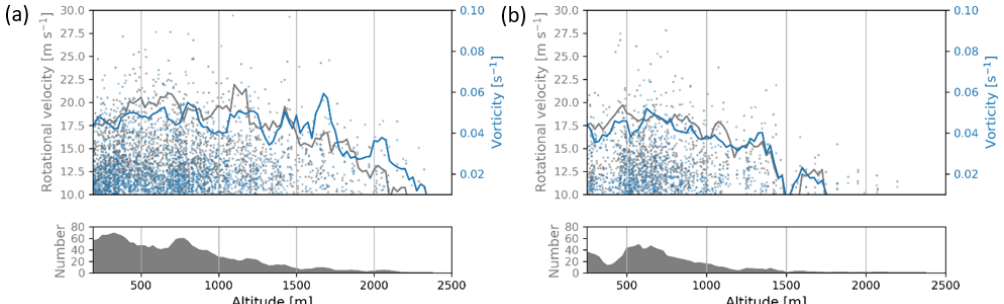
Figure 7. Topographical influence on rotational metrics; scatterplot of rotational velocity and vorticity versus altitude. The grey and blue lines indicate the smoothed 95th percentile; the lower graph shows the number of detection per altitude. (a) Cases detected by the Monte Lema radar (south); (b) cases detected by the Albis and La Dôle radars